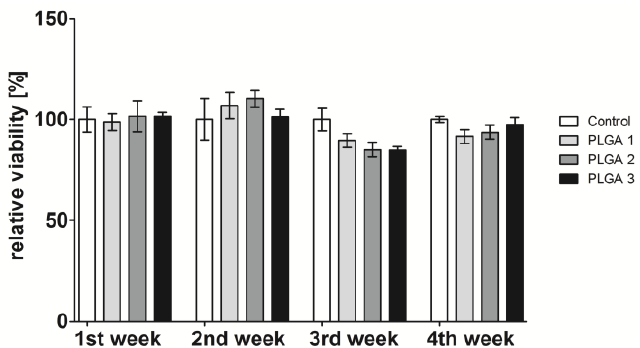
Figure 2. Relative viability of EA.hy926 cells analyzed by MTT assay after incubation with supernatant of incubated PLGA 1–, 2– or 3–coated coverslips. Therefore, 100,000 EA.hy926 cells were seeded in one well of a 24-well plate and cultivated with the supernatant of the respective cultivated PLGA slides for 48 h. For the control group, medium was incubated with coverslips and supernatant added to the cells. The control was set to 100%, each bar represents the mean ± standard error (SEM) of n = 1.